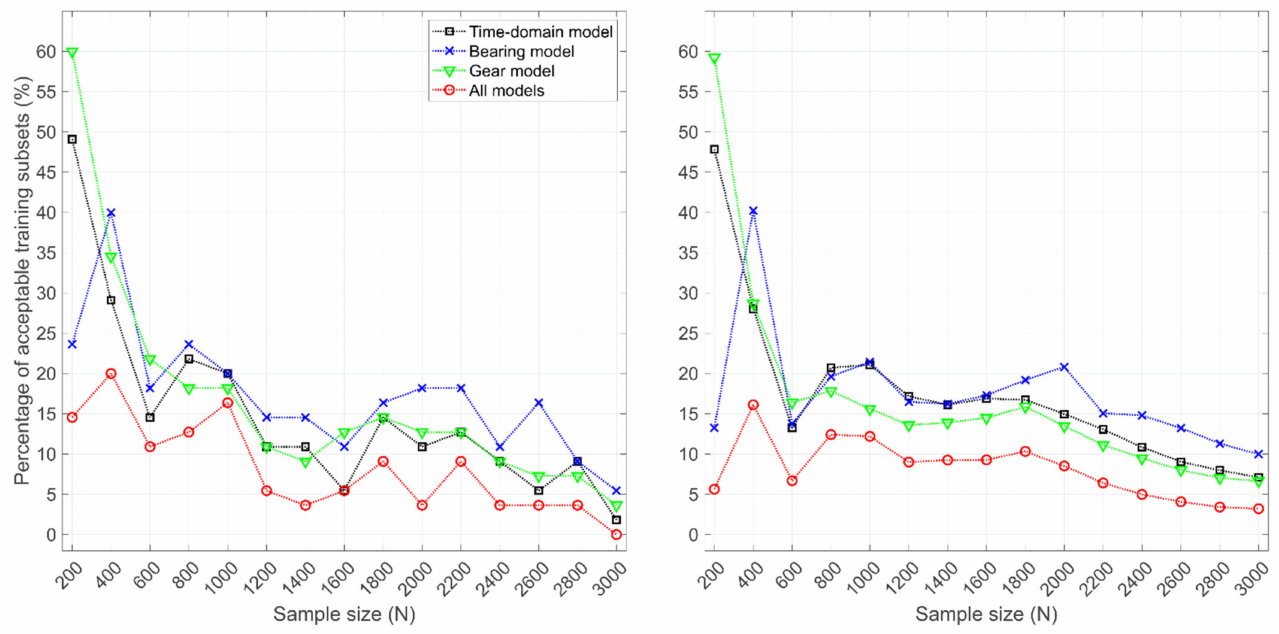
Figure 8. Percentage of acceptable training subsets using different combinations of features. Dataset segmentation approach based on ‘basic training subsets’ on the left and ‘adaptive training subsets’ on the